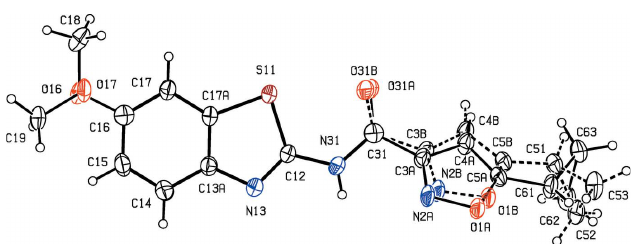
Figure 3 The molecular structure of (III), showing the atom-labelling scheme and the disorder of the cyclopropylisoxazole fragment, where the major disorder component, with occupancy 0.549 (5), is drawn using full lines and the minor disorder component of this fragment, with occupancy 0.451 (5), is drawn using broken lines. The atomic sites O16, O17, C18 and C19 and the associated H atoms all have occupancy 0.5 (see Section 2). Displacement ellipsoids are drawn at the 30% probability level.